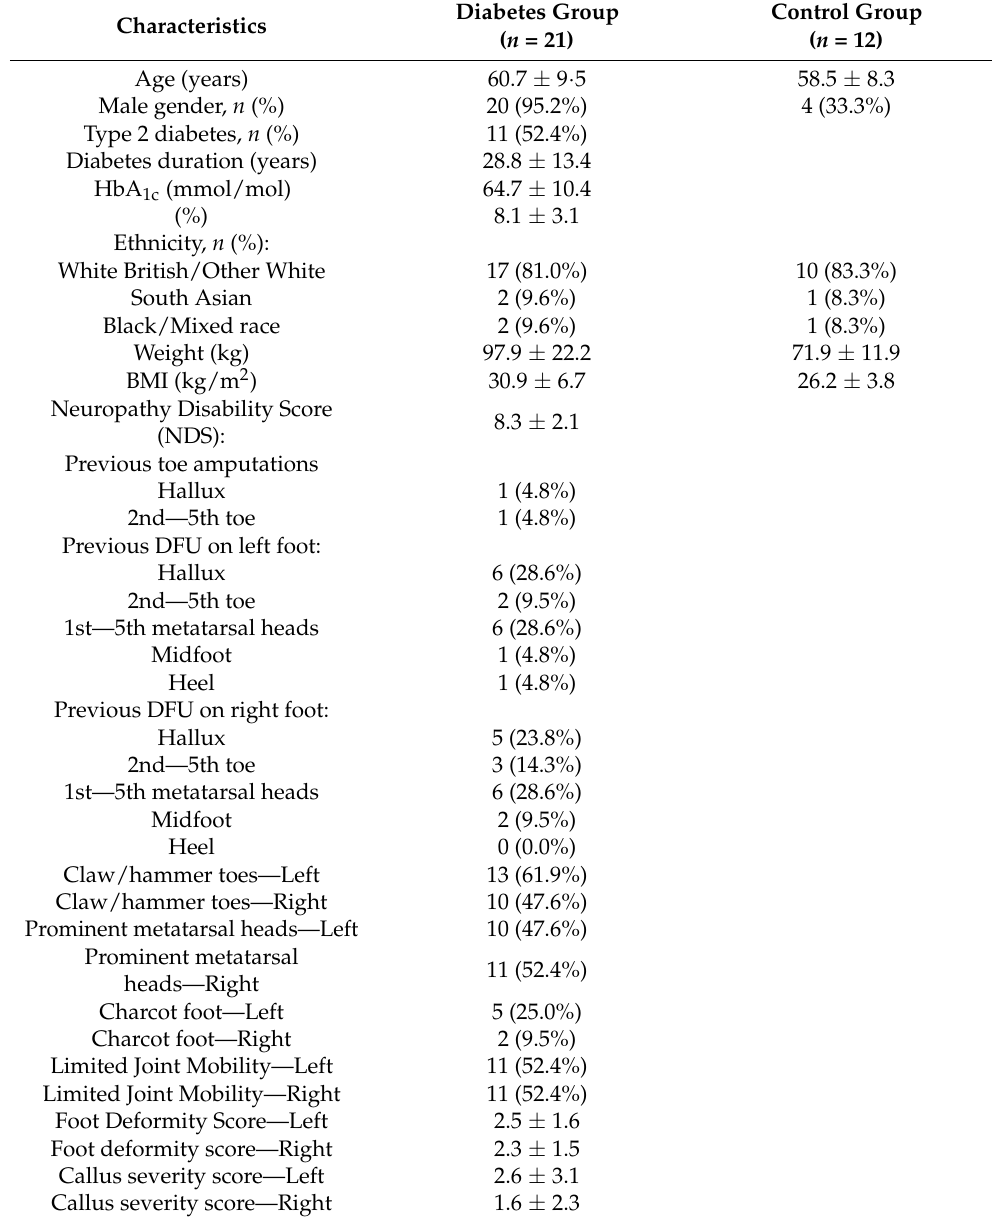
Table 1. Baseline characteristics of participants. Results given as number (%) or mean (SD). Foot deformity score comprised a total of 6 abnormal scores (1) for each of the following per foot: hammer or claw toes, prominent metatarsal heads, small muscle wasting, bony prominences, Charcot, limited joint mobility was determined by assessing range of motion in the finger joints during the prayer sign. Callus severity score—callus severity was assessed at 12 distinct plantar sites per foot (first–fifth toes, first–fifth metatarsal heads, midfoot and heel). Scores were no callus (zero), mild callus (1), medium callus (2) and severe callus (3). Total callus severity scores were recorded for each foot at